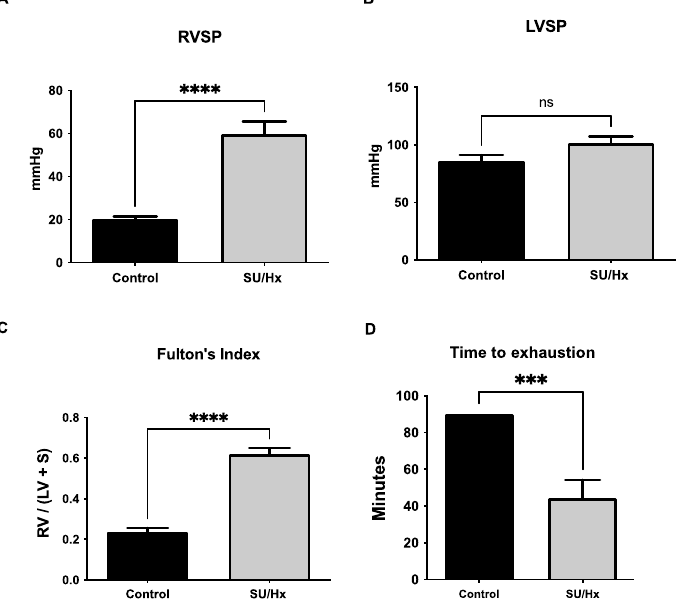
Figure 1. ( A ) Increased ventricular systolic pressure (RVSP) in SU/Hx-induced PH rats is seen, and ( B ) no significant difference on left ventricular systolic pressure (LVSP) can be seen when they are compared to those of the controls. ( C ) Right ventricular hypertrophy was assessed by Fulton’s Index (ratio of right ventricular weight to left ventricular and septal weight) in SU/Hx-induced PH rats and this is compared to that of the controls. ( D ) Decreased endurance for SU/Hx animals in treadmill exercise testing. Average time running for SU/Hx-induced PH rats is compared to that of the controls. Values are expressed as the mean ± SEM for six animals per group. Statistical analysis is conducted by a Student’s t -test, *** p < 0.001, **** p < 0.0001, ns: not